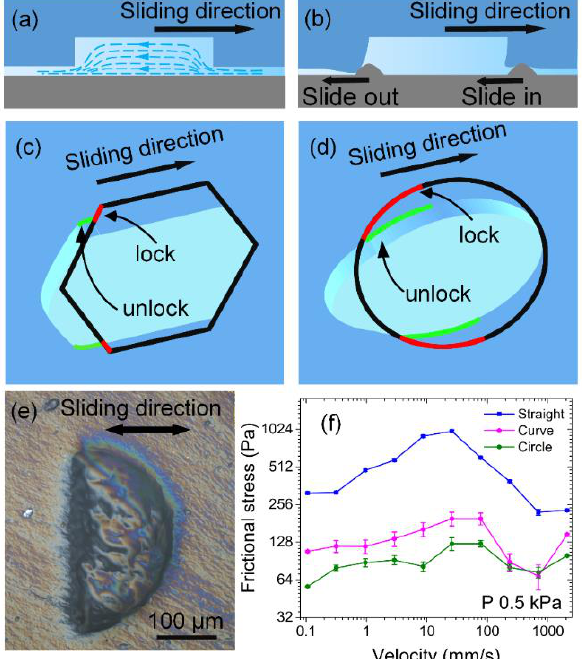
Figure 6. A schematic of the frictional-wear mechanism. ( a ) Fluid lubrication in a micro-pit. ( b ) Sub- strate micro-protrusions interlocking with a micro-pit. Deformation of ( c ) hexagonal and ( d ) circular micro-pits; black: micro-pit profiles before tensile deformation, red: trailing edges that would have interlocked before deformation, green: trailing edges that would haven't interlocked with micro- protrusions on the substrate after deformation have been transformed from red profiles. ( e ) A confocal plot of a semicircular pit. ( f ) Frictional stress on a semicircular profile.